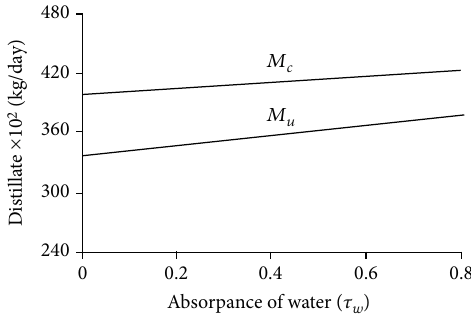
Figure 32: E ff ect of water absorbance on distilled water ( M coupled solar still and M